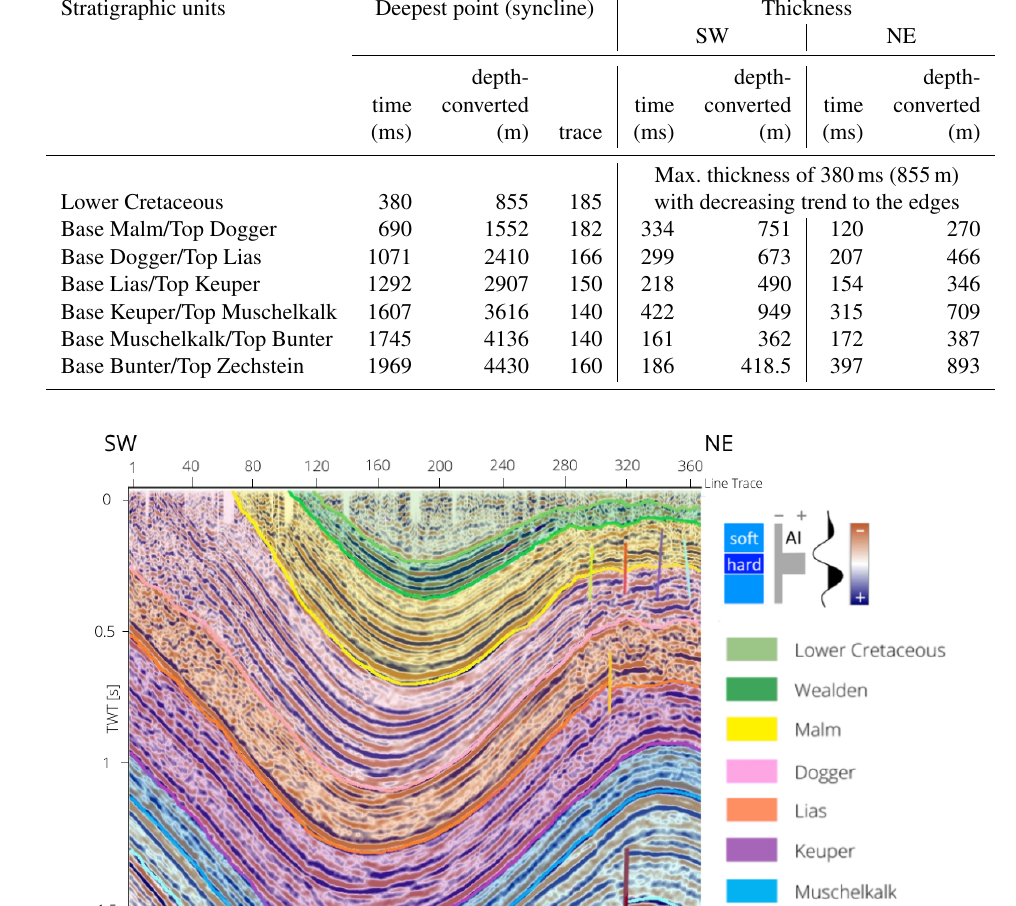
Table 3. Compilation of results of the seismic interpretation. The table shows the depth and thicknesses of the different stratigraphic units in milliseconds and converted to meters.